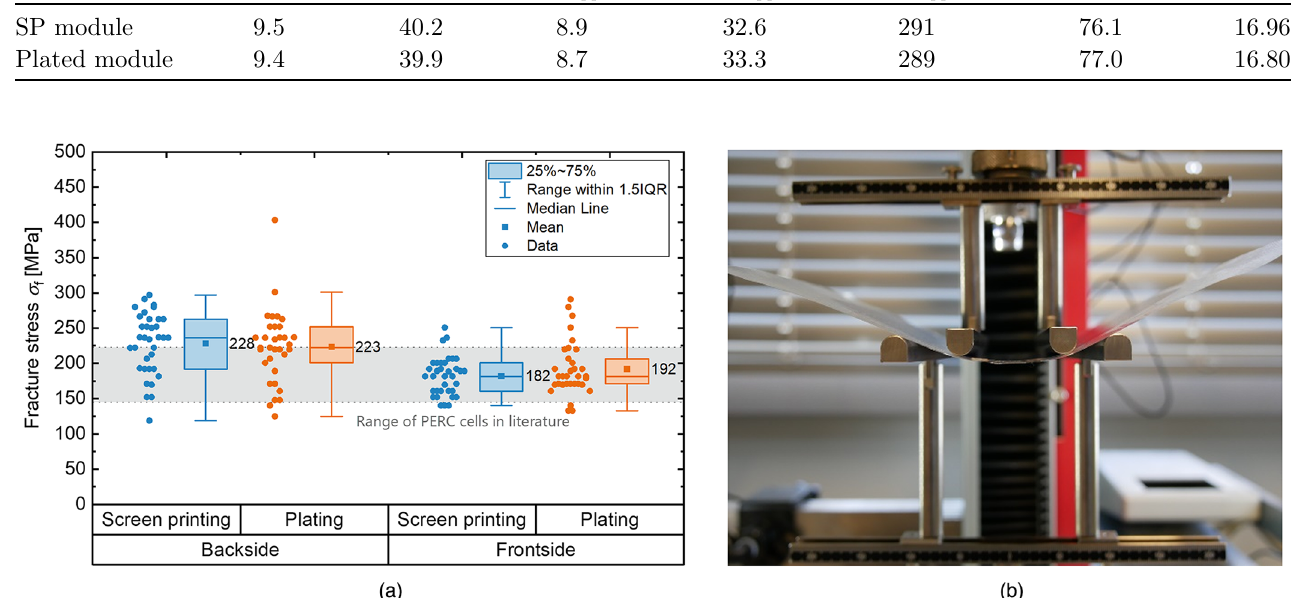
Table 1. IV module results of the plated or screen-printed (SP) bifacial TOPCon modules shown in Figure 4. Modul